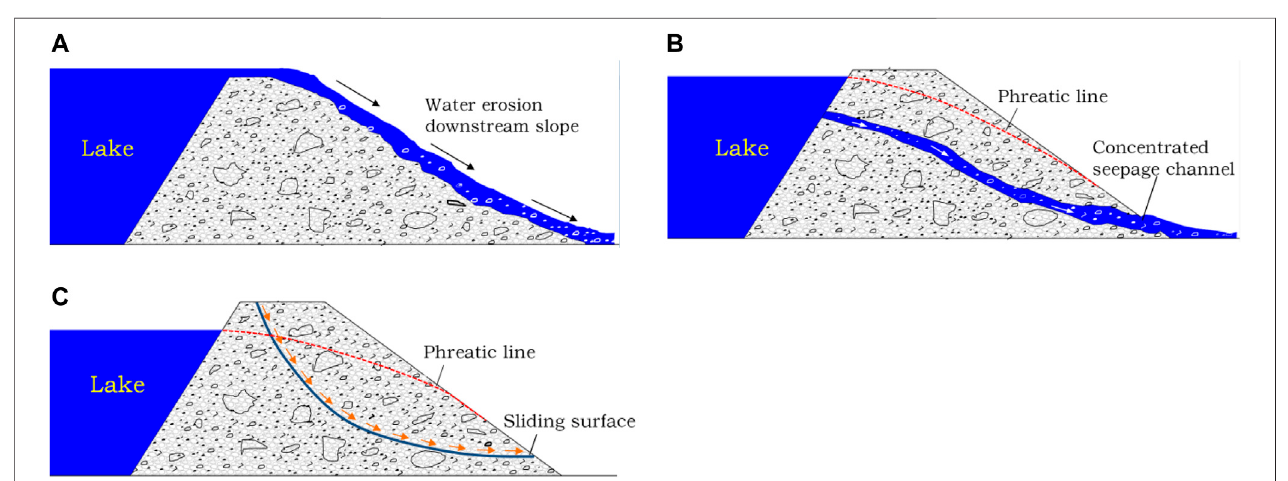
Frontiers in Earth Science |